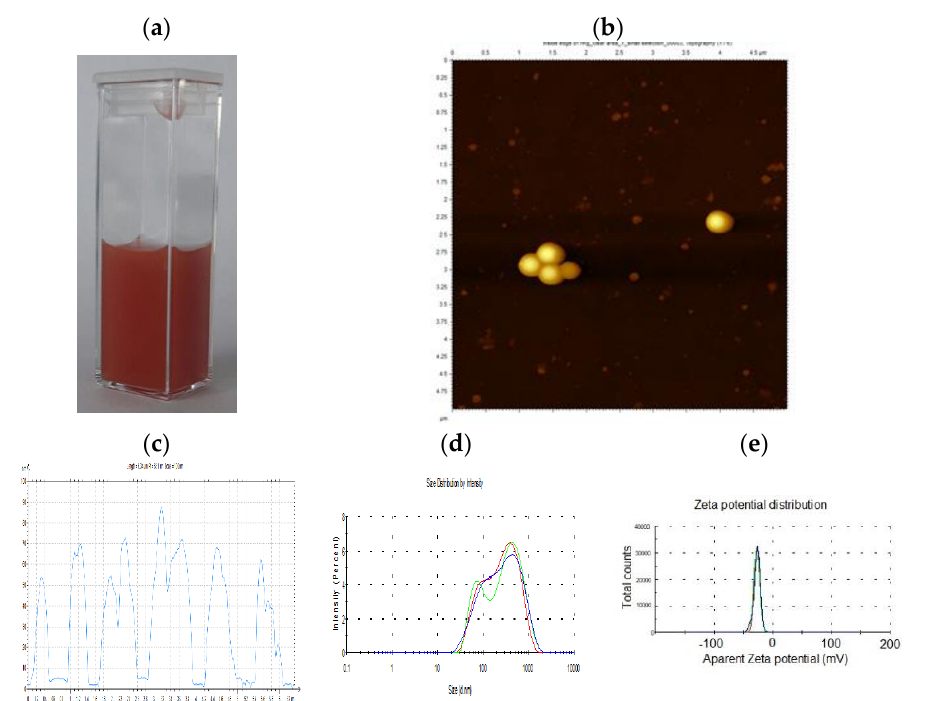
Figure 1. ( a ). The characteristic red colour of SeNPs. ( b ). AFM of SeNPs biosynthesized using L. casei and NaHSeO 3 as a reducing agent. ( c ). Surface profile of SeNPs recorded from AFM. ( d ). Size distribution measurement of SeNPs. ( e ). Apparent Zeta potential records of SeNPs.